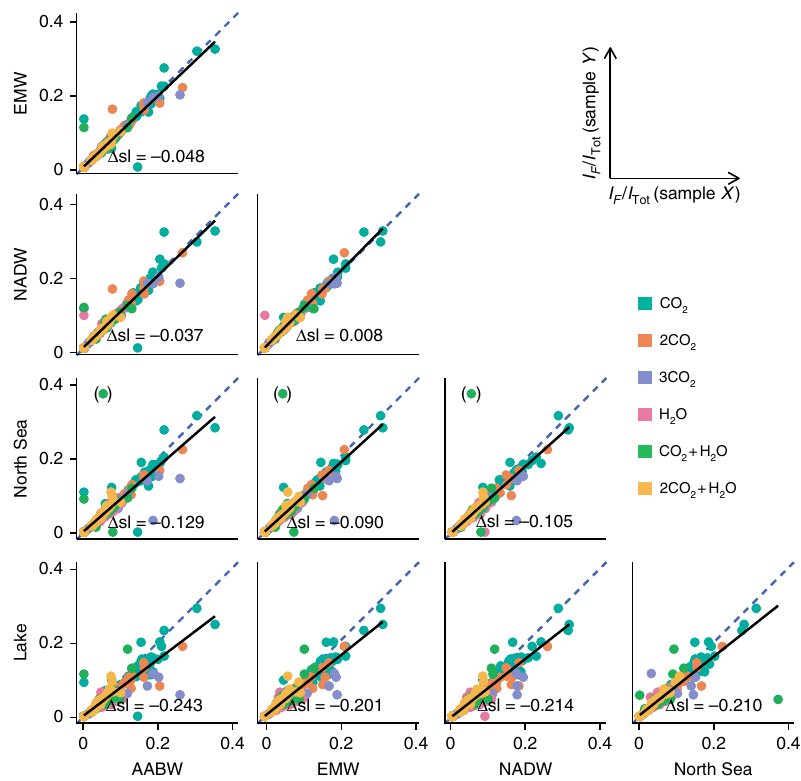
Fig. 2 Structural relation of DOM from different environments. Linear regression analysis of relative fragment ion intensities from common molecular formulae shows the structural variance between two samples indicated by the signi fi cance of the correlation (all p < 0.0001, n = 324) and the deviation of the slope ( Δ sl) from ideal conformity (blue dashed lines). One outlier (in parentheses) was excluded from regression analysis. AABW Antarctic Bottom Water; EMW Eurafrican Mediterranean Water; NADW North Atlantic Deep Water